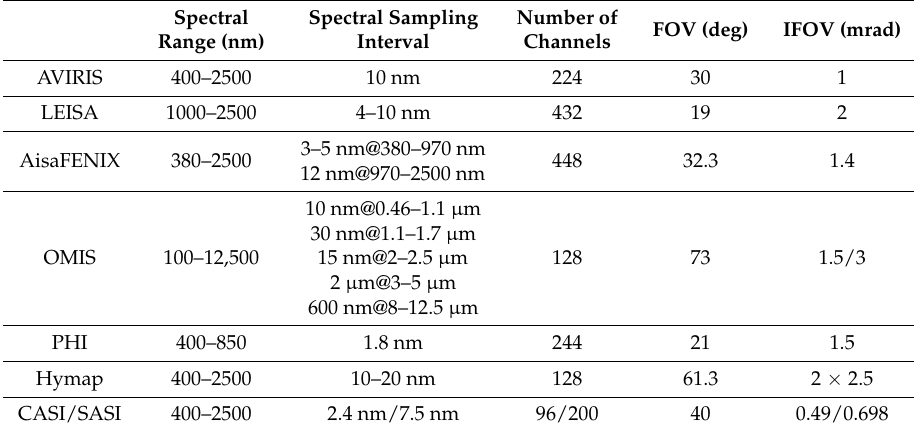
Table 1. Main features of some typical airborne hyperspectral imaging systems.